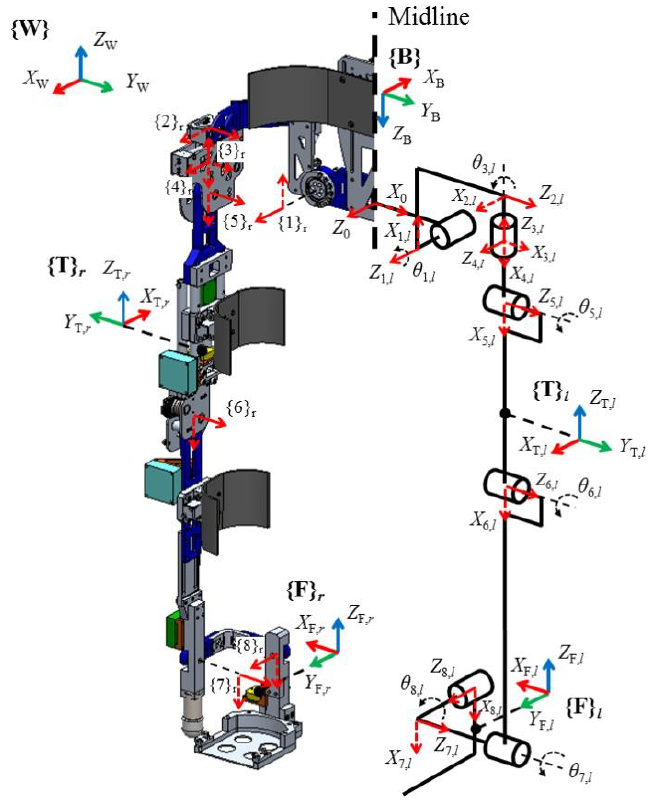
Figure 13. Kinematic model of the exoskeleton and its frame attachment.